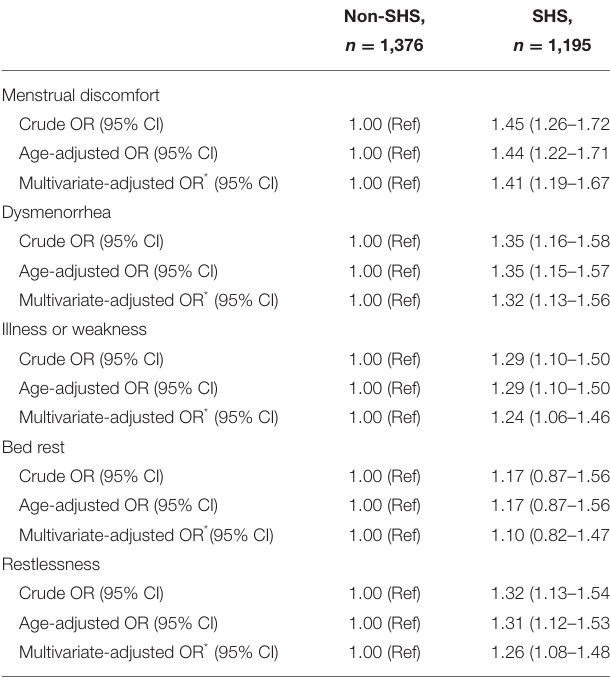
TABLE 3 | ORs and 95% CIs for nurses’ menstrual discomfort symptoms according to exposure to SHS among nonsmokers ( n = 2,571).